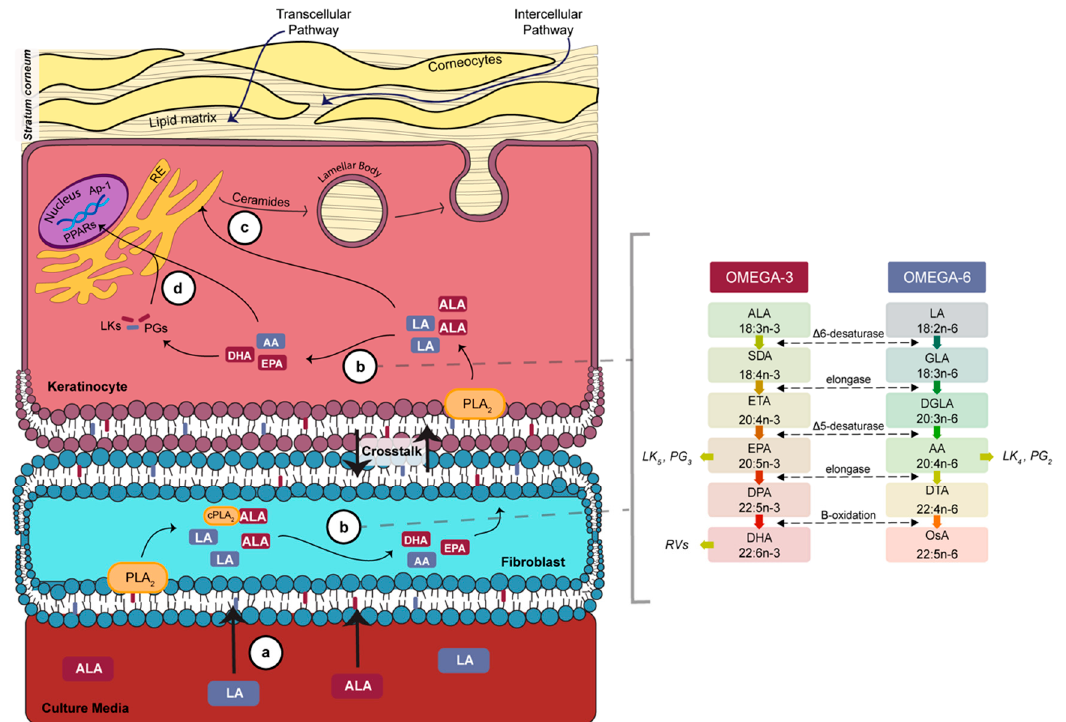
Figure 5. Schematic overview of n-3 and n-6 metabolism in the skin at the air-liquid interface. ( a ) The ALA and LA PUFAs added into the culture media are incorporated into the phospholipids of cells in contact with the media. During the air-liquid interface culture period, keratinocytes are no longer in contact with the culture media and PUFAs must be provided from the crosstalk with fibroblasts. ( b ) The PLA 2 hydrolyzes PUFAs from the phospholipids. ALA and LA can be converted by a series of desaturation and elongation reactions in both fibroblasts and keratinocytes. ( c ) After phospholipid hydrolysis, PUFAs can also be brought to the endoplasmic reticulum where they are transformed into more complex lipids such as ceramides. Lipids are stored in lamellar bodies, which then merge with the cell membrane, releasing their content and thus forming the intercellular lipid matrix. ( d ) PUFAs such as EPA and DHA are activators of PPARs, which regulate keratinocyte di ff erentiation. Abbreviations: AA, arachidonic acid; ALA, α -linolenic acid; Ap-1, activator protein 1; COX, cyclooxygenase; cPLA 2 , cytosolic phospholipase A2; DGLA, dihomo- γ -linolenic acid; DHA, docosahexaenoic acid; DPA, docosapentaenoic acid; DTA, docosatetraenoic acid; EPA, eicosapentaenoic acid; ETA, eicosatetraenoic acid; GLA, γ -linolenic acid; LA, linoleic acid; LK, leukotriene; LOX, Lipoxygenase; OsA, osbond acid; PG, prostaglandin; PLA 2 , phospholipase A2; PPAR, peroxisome proliferator-activated receptor; PUFAs, polyunsaturated fatty acids; SDA, stearidonic